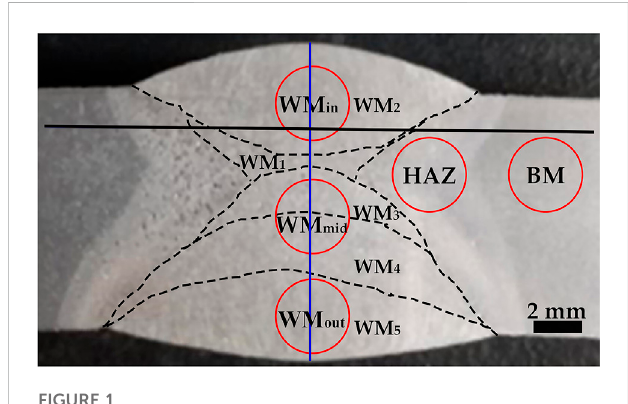
FIGURE 1 Macroscopic morphology of the welded